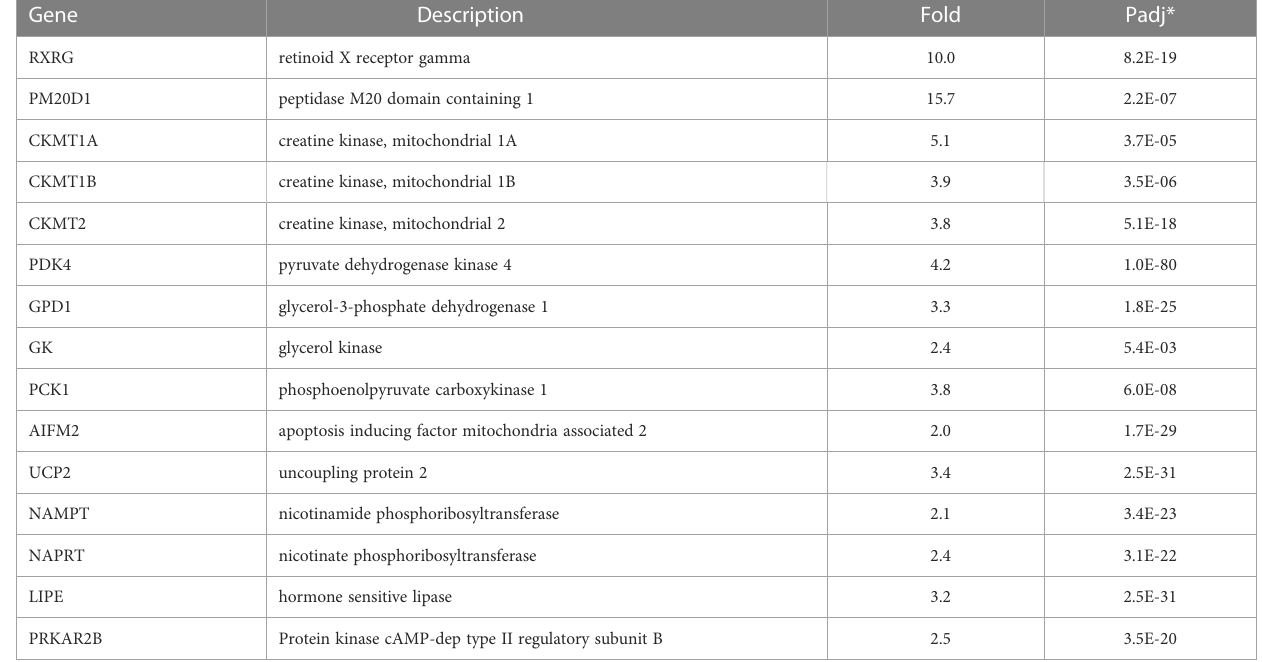
TABLE 3 Thermogenesis genes upregulated by NRBC.